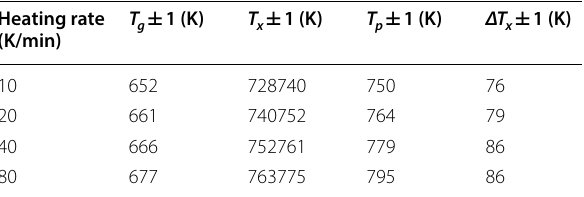
Table 2 Characteristic temperatures of Zr BMG with different heating rates